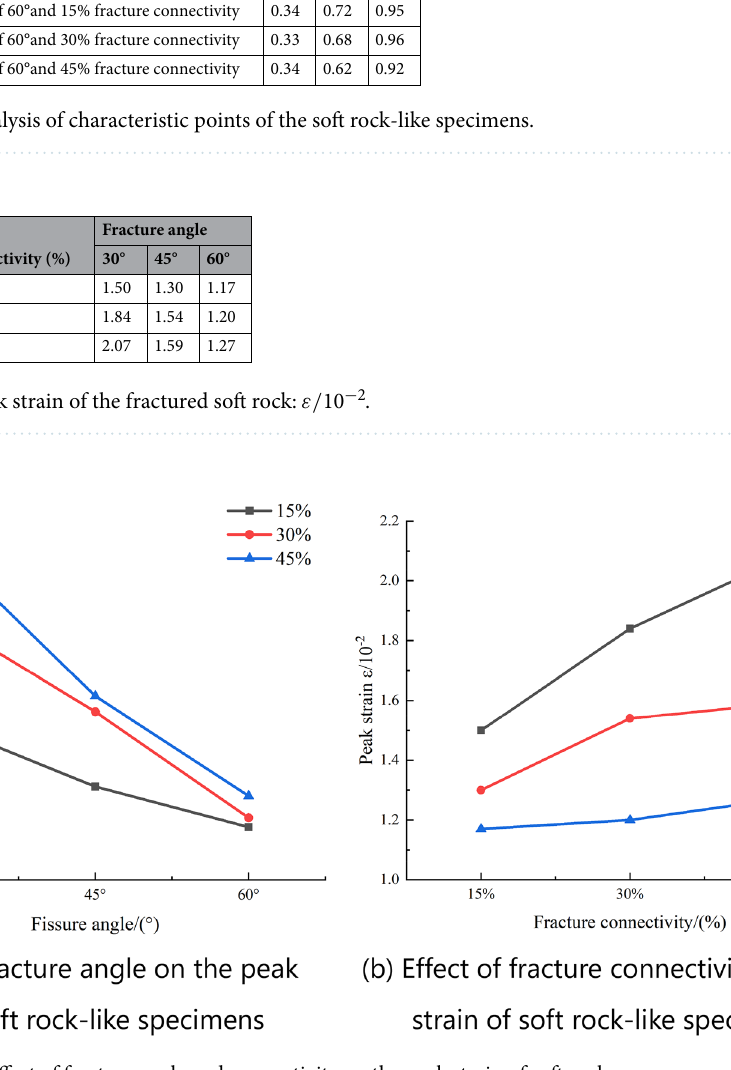
Figure 13. Effect of fracture angle and connectivity on the peak strain of soft